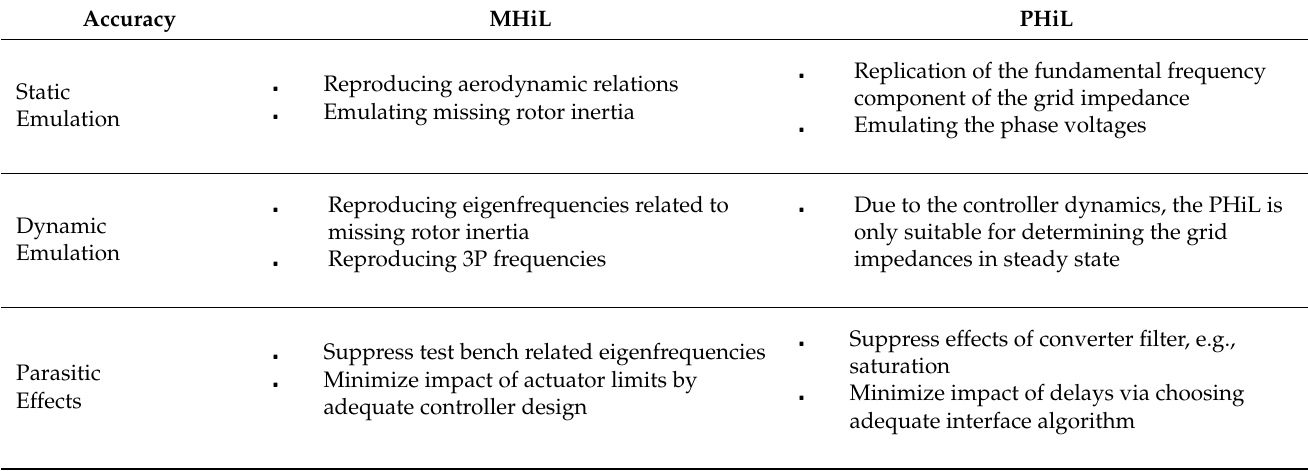
Table 1. List of tasks and effects for HiL systems and a comparison what they mean in the differ- ent